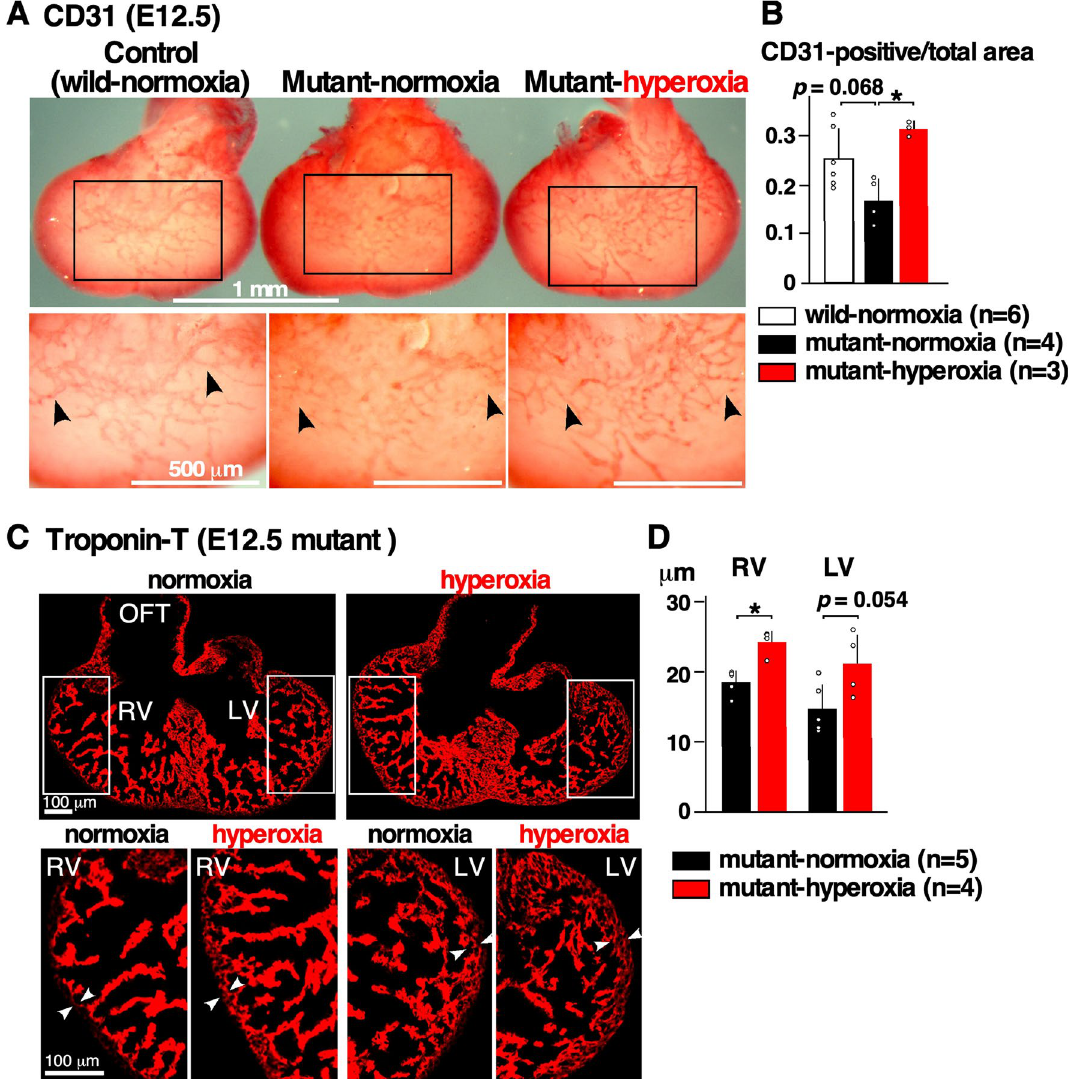
Figure 3. Defective coronary vessel organization in E12.5 Nkx2-5 mutant embryonic hearts, and the effects of hyperoxia. ( A ) Dorsal view of whole-mount CD31 immunostaining of ventricles showing endothelial cell plexus organized within the ventricles. CD31 staining was less prominent and extended to the apical area in Nkx2-5 mutant heart at normoxia, but was comparable at hyperoxia to the control wild-type heart (black arrowheads). ( B ) Quantitative CD31-positive area relative to the entire ventricular area. The number of embryos examined is indicated. The non-parametric Kruskal–Wallis ANOVA with Dunn’s test was used for analysis. ( C ) Representative heart sections stained with troponin-T. Thickness of compact layer is shown in white arrowheads. ( D ) Quantitative data showing thickness of compact layer in Nkx2-5 mutant hearts at normoxia vs. hyperoxia. The Mann–Whitney U test was used for analysis. Data are expressed as mean ± S.D.; individual data are represented as circles. * P ≤ 0.05. LV left ventricle, RV right ventricle, OFT outflow tract. The number of mice examined is indicated. ImageJ 1.52d (http:// imagej. nih. gov/ ij) was used for